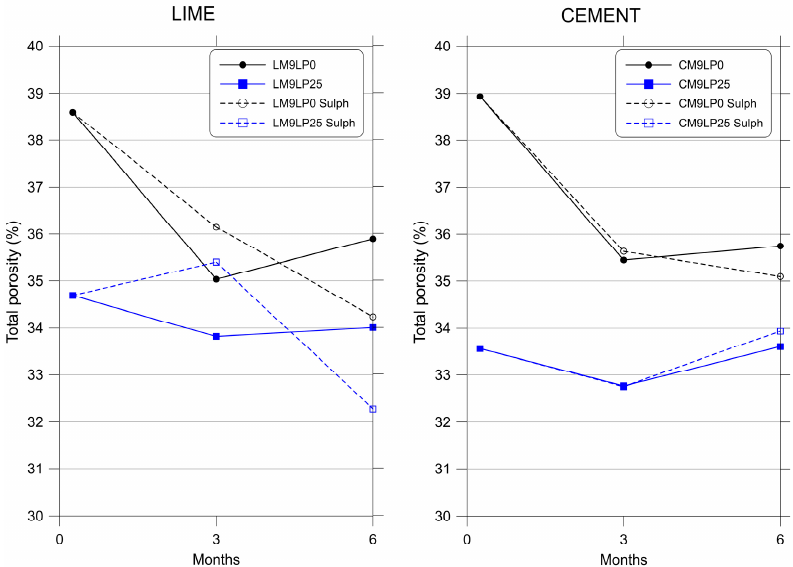
Figure 4. Total porosity of the lime and cement samples with and without the industrial waste at 7 days and at 3 and 6 months.